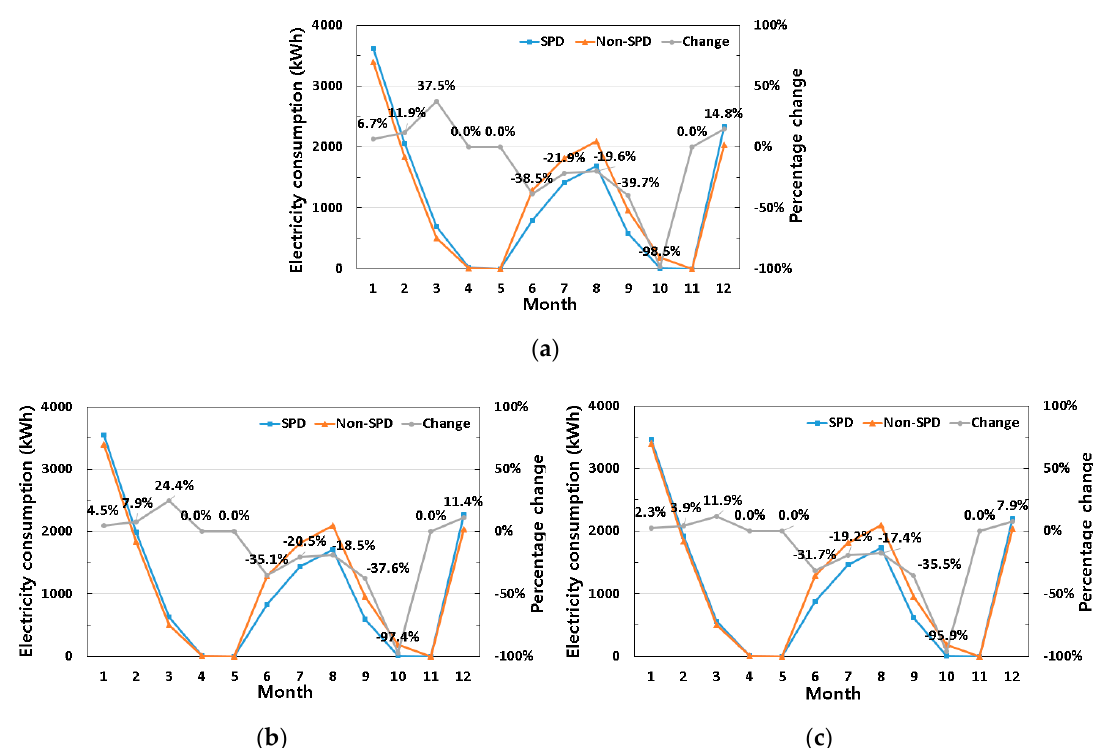
Figure 13. Electricity consumption of SPD/non-SPD models and variation compared to non-SPD model according to the controllable solar heat gain coefficient (SHGC) range: ( a ) 0.11–0.35; ( b ) 0.11–0.4; ( c ) 0.11–0.45.